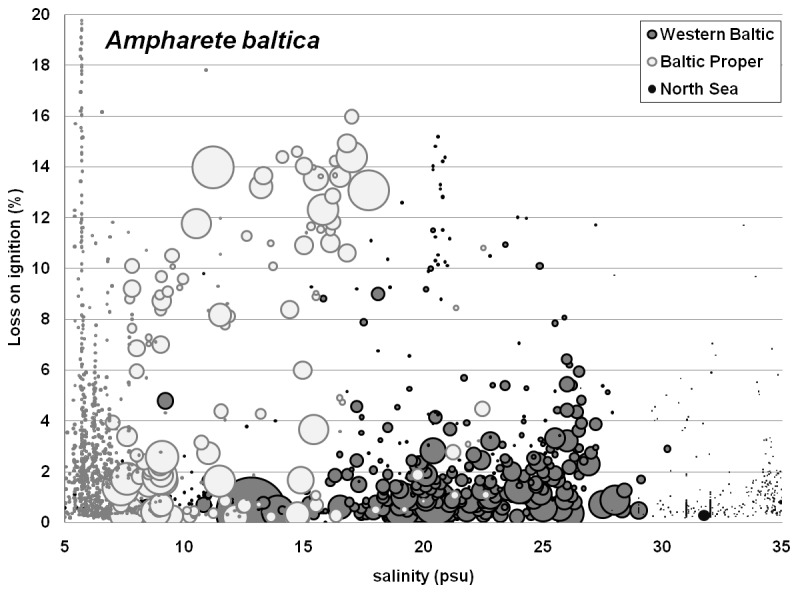
Abundance of Ampharete baltica in relation to bottom salinity and organic sediment content in three sea areas.The relative bubble size indicates the density of the species with smallest dots referring to species absence and largest bubble size to ca. 1700 ind/m2. Note that the symbol shading used in Figures 2, 3 and 5 is not consistent as different issues are shown.